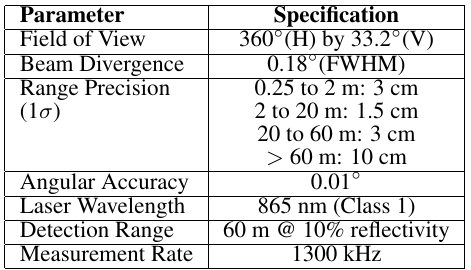
Table 2. Manufacturer Instrument Specifications for Ouster OSI-64 (Source: